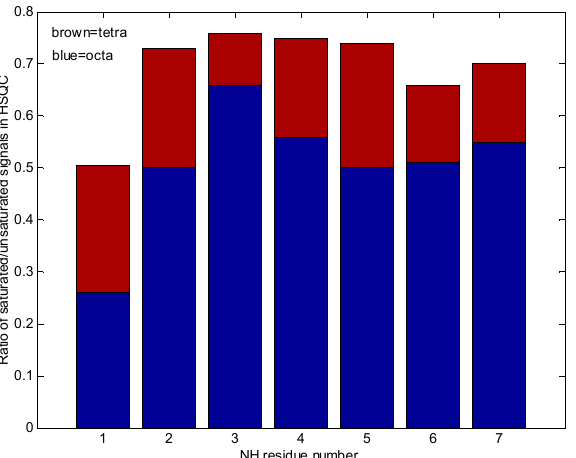
Figure 10. In this "pile up" bar graph, the tetra and octameric eremomycin water saturation effi- ciencies are compared. The smaller the contribution, the higher the probability of solvent access to that site.